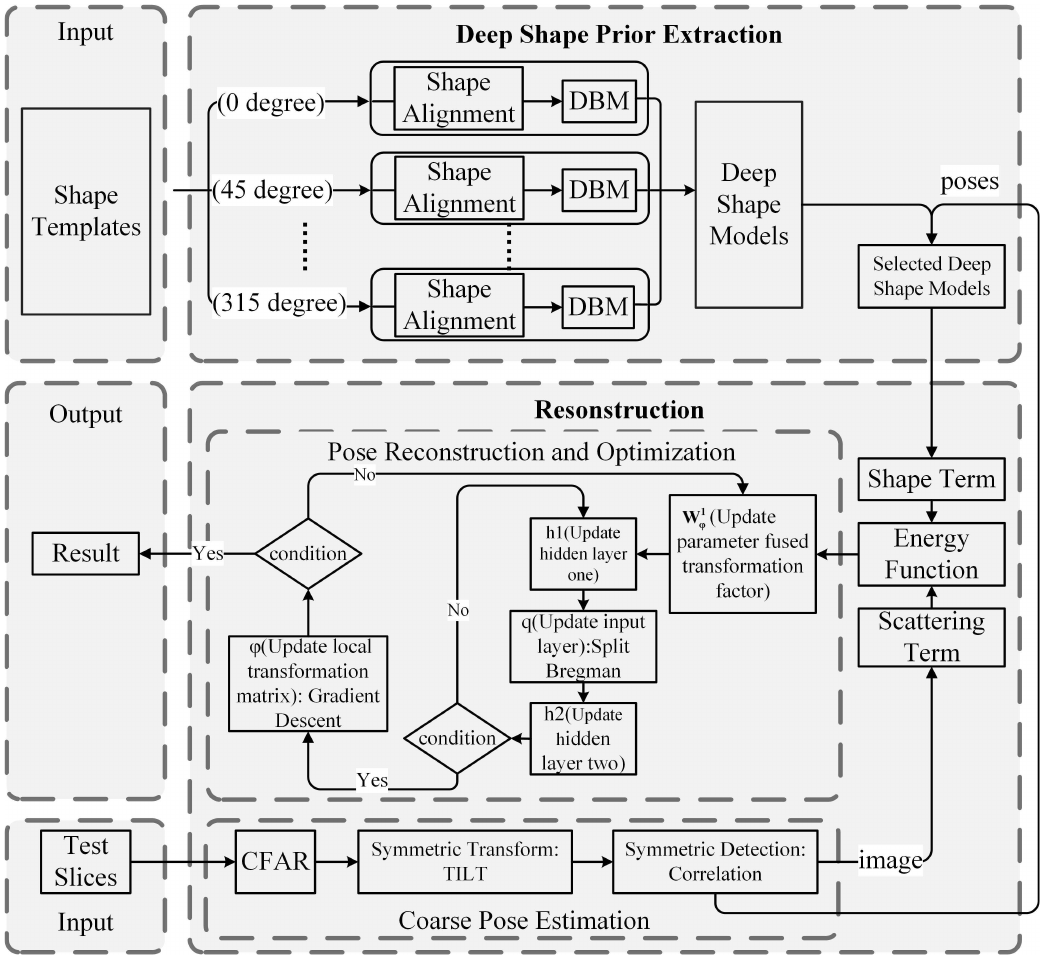
Figure 6. The workflow of the proposed aircraft reconstruction. h 1, h 2, and q represent the first hidden layer, the second hidden layer of DBM, and the shape of the object, respectively. DBM: deep Boltzmann machine; CFAR: constant false alarm rate; TILT: transform-invariant low-rank